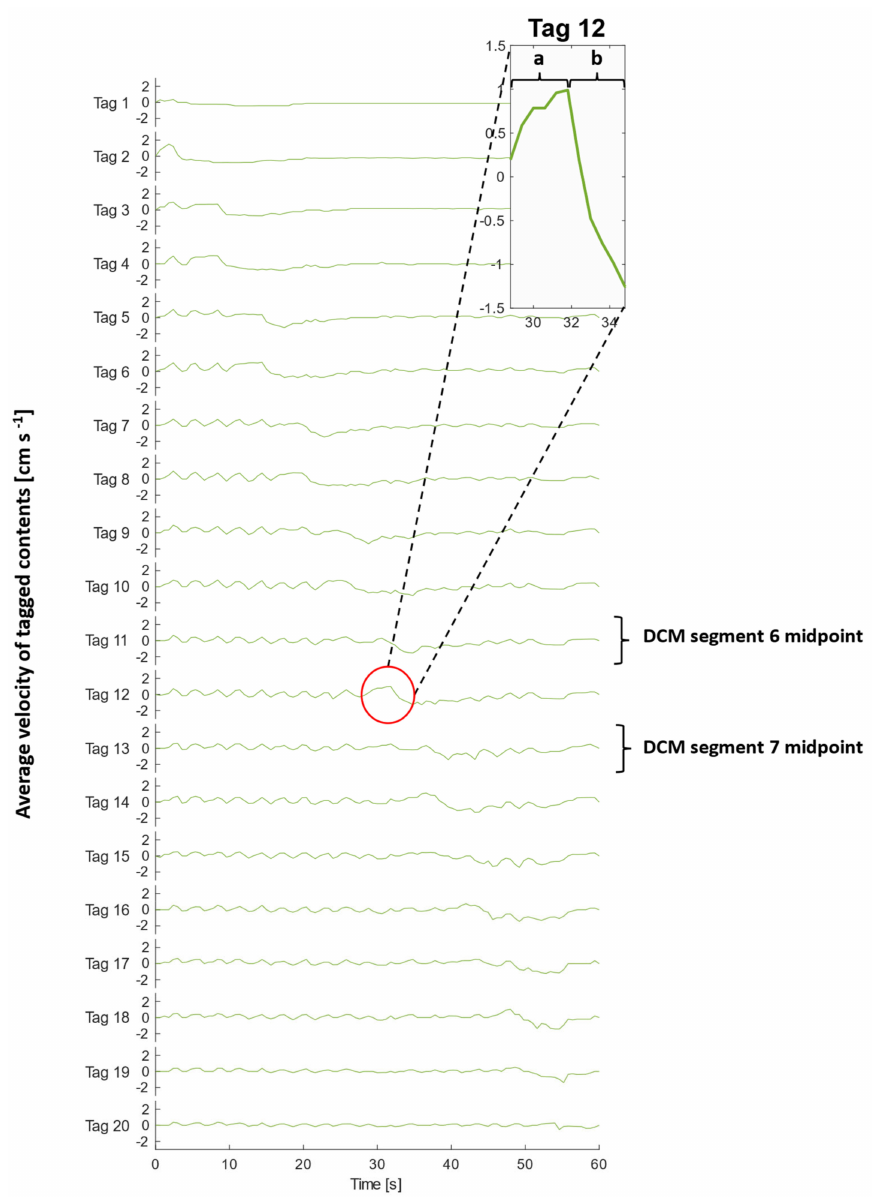
Figure 4. Average velocities of tagged DCM contents (200 mL LOVIS fluid) at each time point during a CPPW. Tag 1 is closest to the caecum , whilst tag 20 is closest to the hepatic flexure. The inset graph displays a magnified plot of tag 12 during (a) contraction of segment 6 and relaxation of segment 7 and (b) contraction of segment